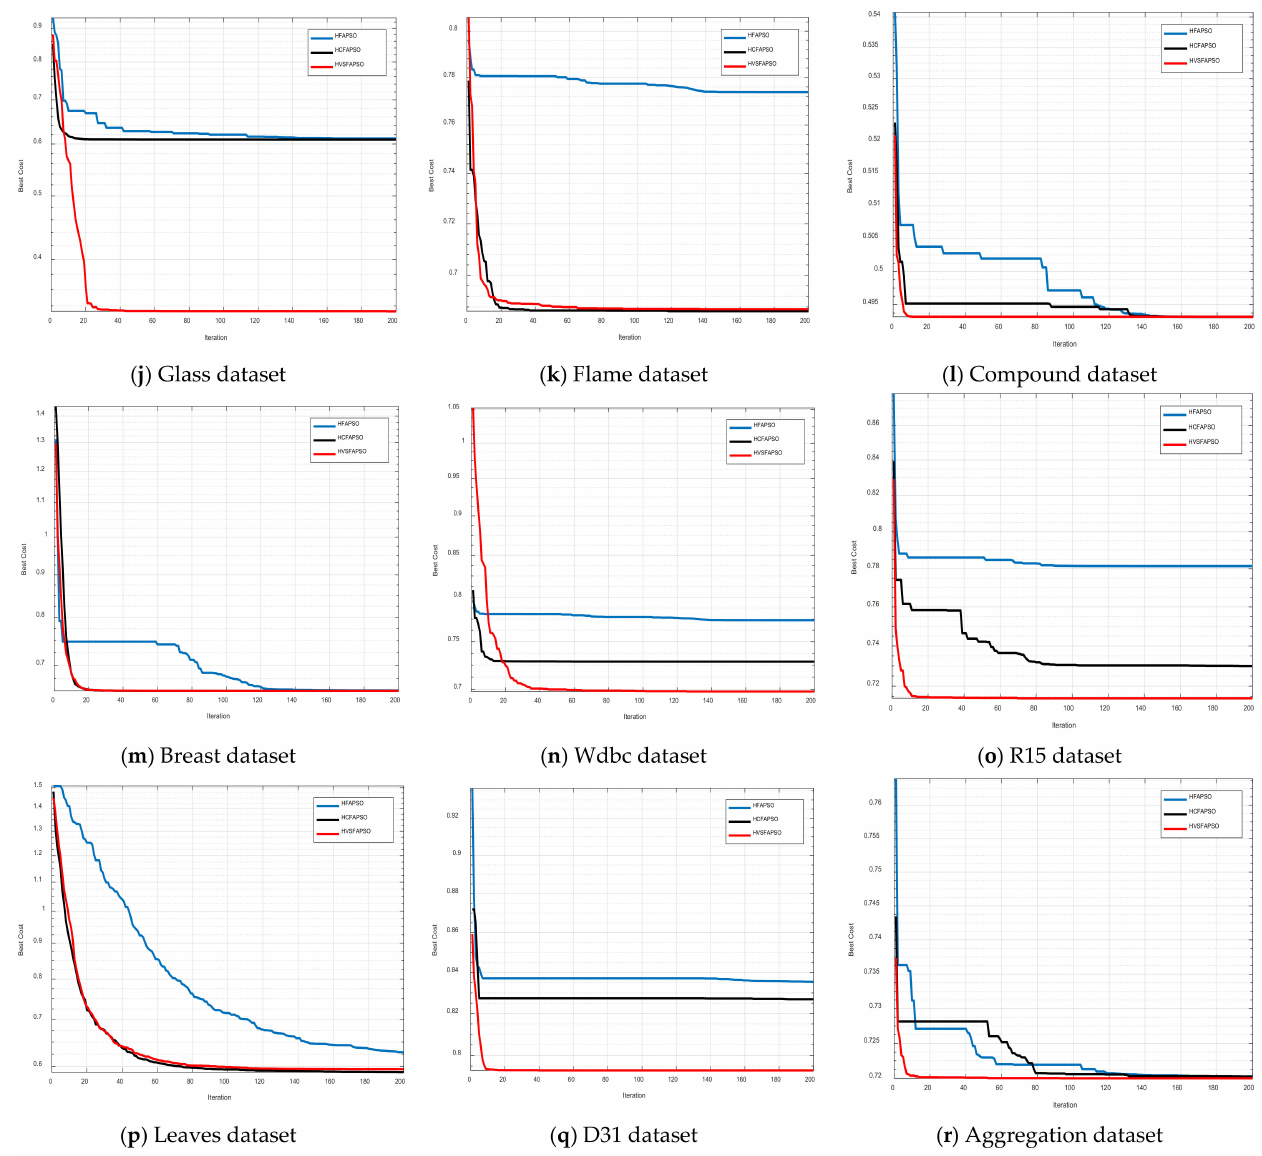
Figure 9. Convergence curves for all used datasets on DB